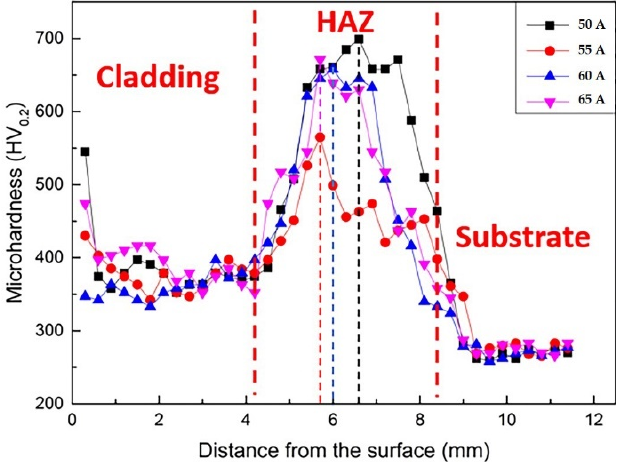
Figure 7. Microhardness distribution along the top surface to the substrate across the cross-section of the CoCrFeNiMn HEA coatings.